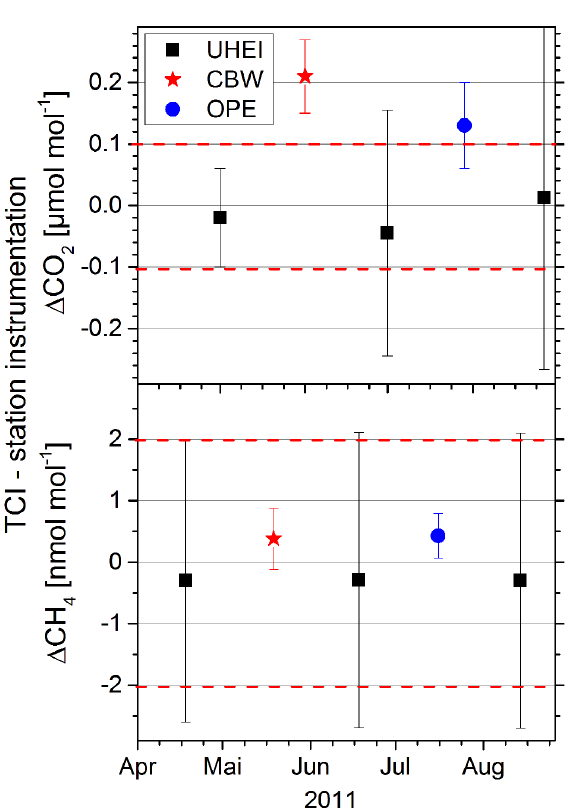
Fig. 6. Summary of the differences of atmospheric measurements and their 1 σ standard deviations (Gauss fit) between the TCI and the respective stations for CO 2 (upper panel) and CH 4 (lower